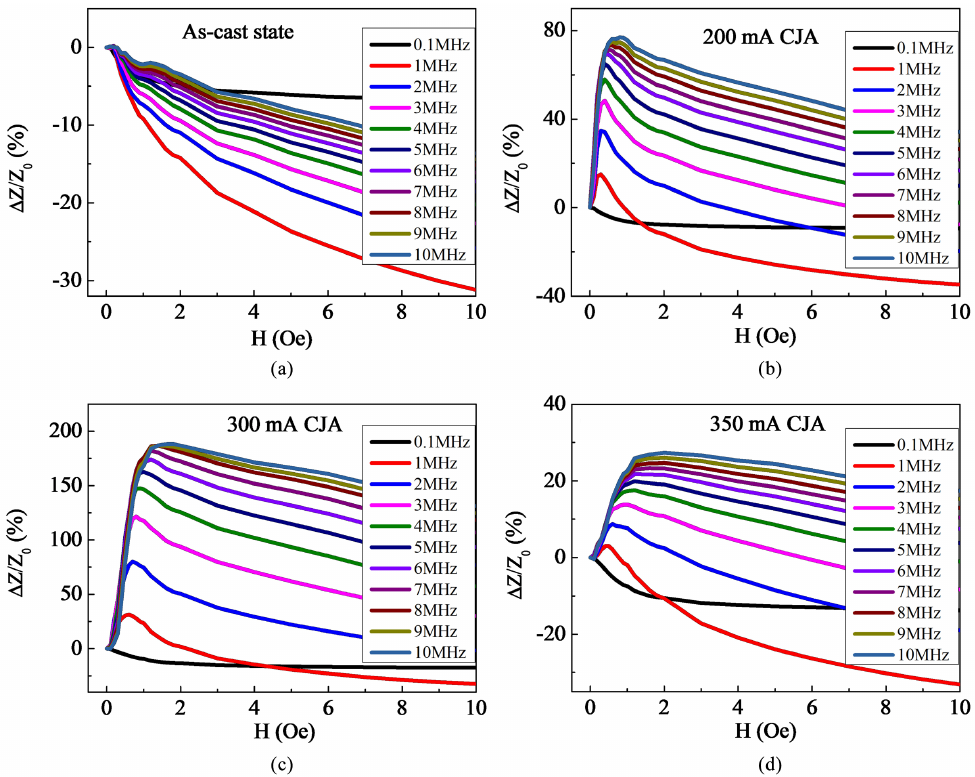
Figure 2. Field dependence of GMI curves measured with selected CJA-ed sample for t =240 s. (a) As-cast; (b) 200 mA; (c) 300 mA; (d) 350